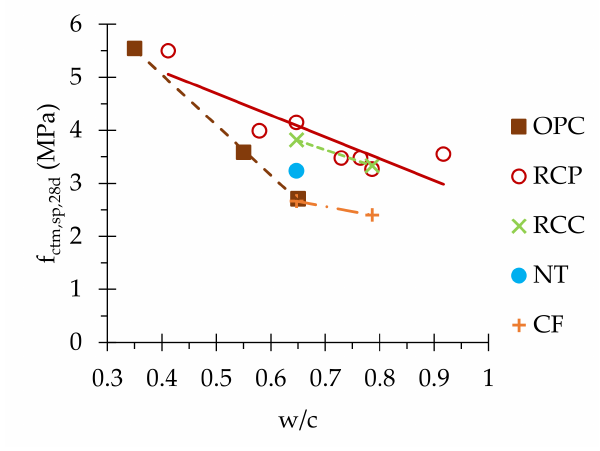
Figure 17. Tensile splitting strength at 28 days, f ctm , sp ,28 d , of the produced concretes as a function of the w/c.